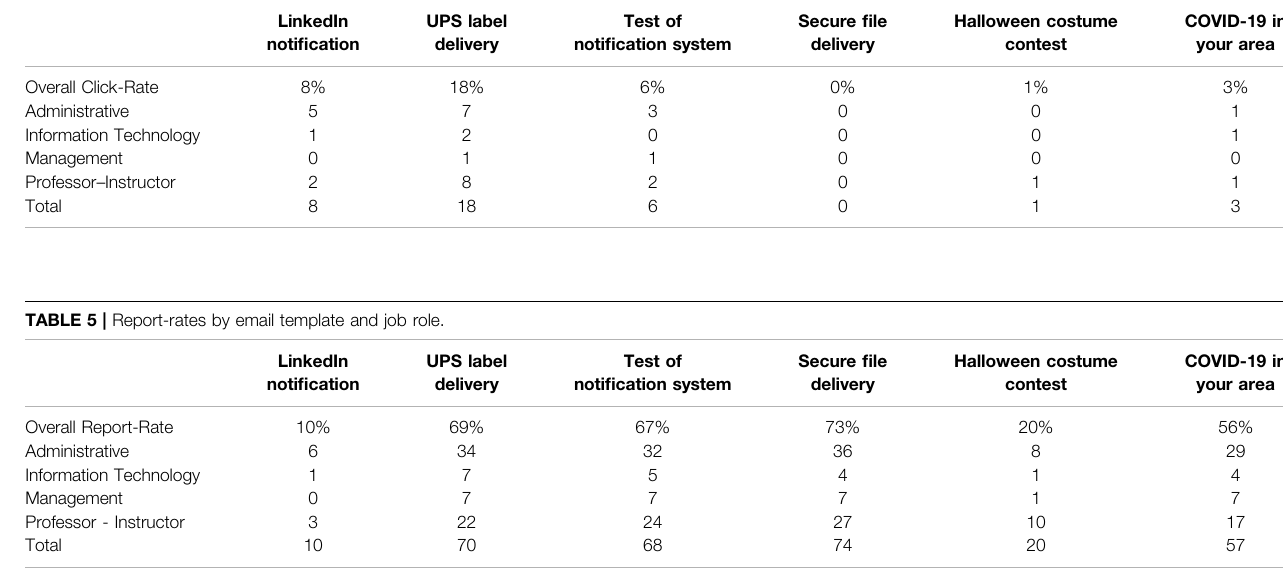
TABLE 4 | Click-rates by email template and job role.